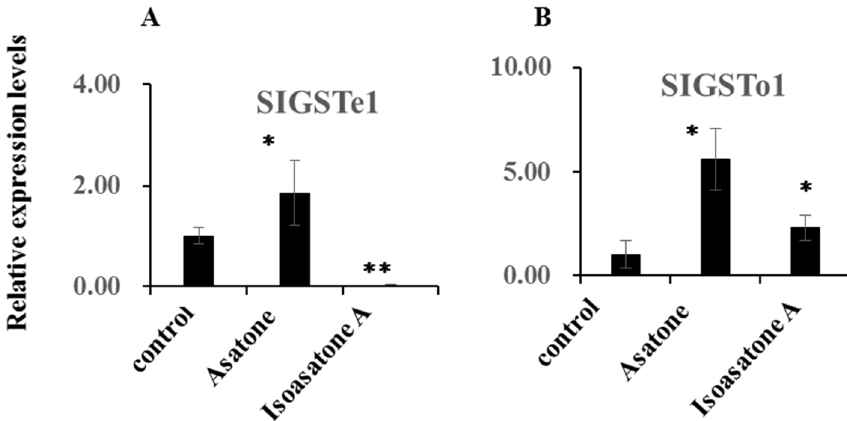
Figure 5. Expression levels of selected genes. ( A , B ) GSTs, β -actin gene served as an internal reference to determine relative expression levels. Data shown are mean +/ − s.e.; n = 3–5. Asterisks indicate significant differences relative to control (* p < 0.05, ** p < 0.01) in a t -test.